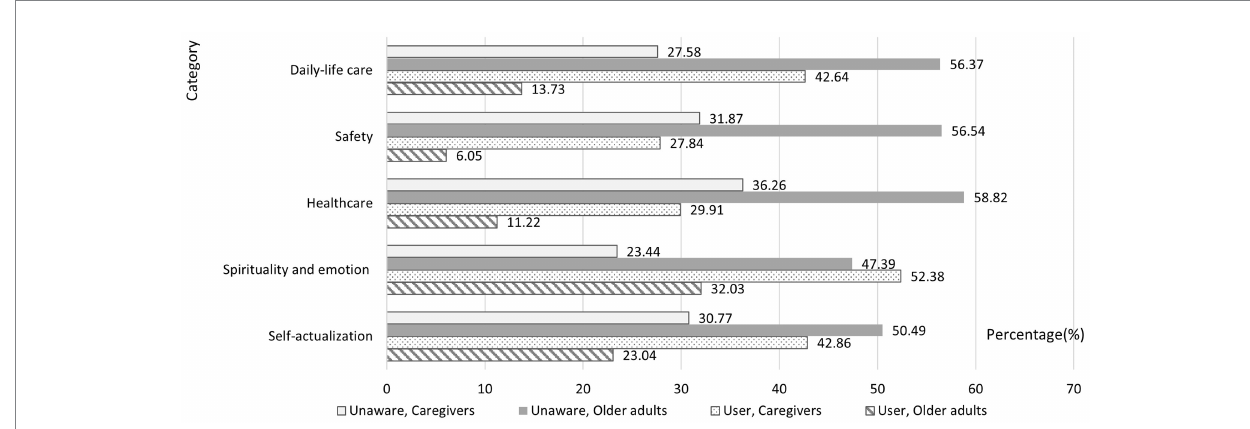
FIGURE 1 Comparison of the awareness and use of different categories of SG&Ss between older adults and caregivers. A small number of respondents insisted they wanted to “think about it later” or said, “I really do not know, it is difficult to make a judgment,” so there was an average of about one respondent who did not make a choice for each item. The total is the average for the 27 items, with all samples counted in the